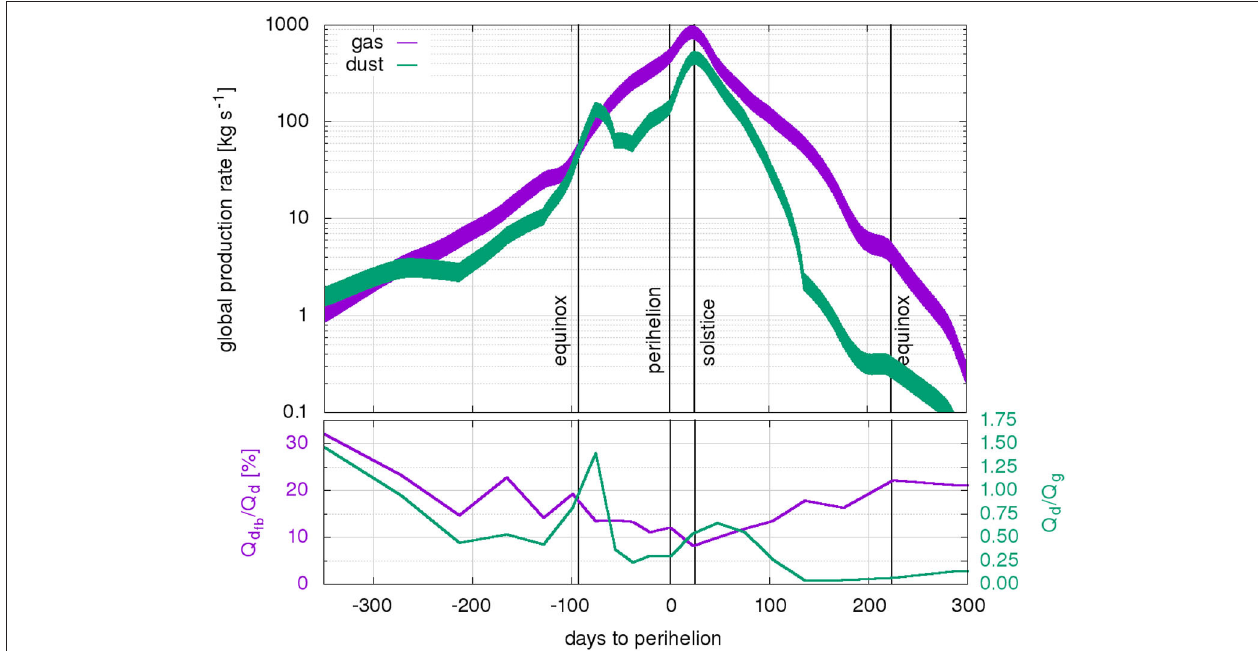
FIGURE 11 | The top panel shows the global production rate for the gas (purple) and dust (green) as a function of days to perihelion. The bands indicate the range due to the diurnal variation. The gas production rates have been constrained by ROSINA/COPS measurements while the dust production rates are from combined constraints of OSIRIS and gas fluxes. For the dust a minimum size of r min = 0.1 µ m and power-law exponent of q = 3.75 are assumed. The bottom panel shows the fraction of dust fall-back (purple) and dust-to-gas ratio